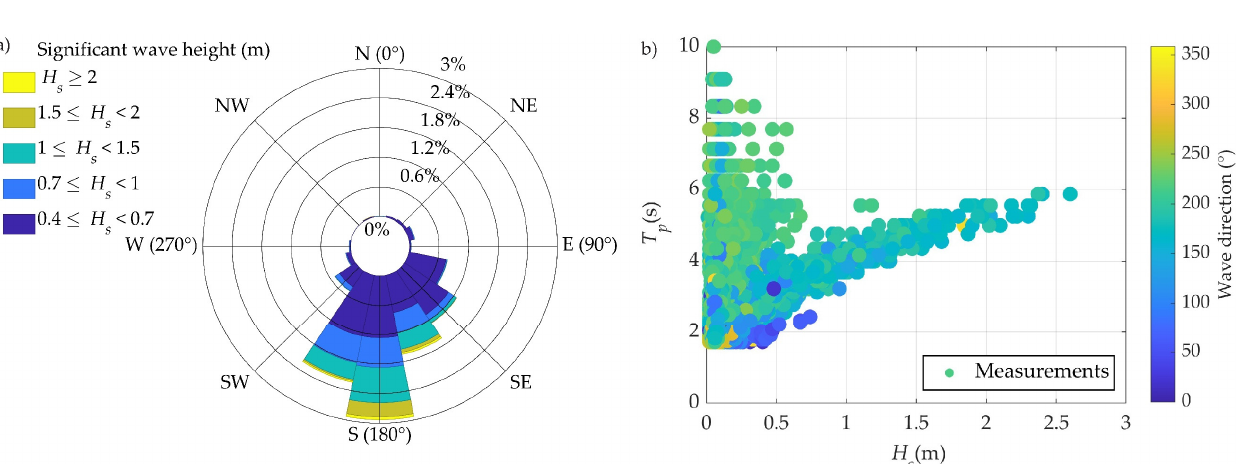
Figure 4. The daily averaged and daily maximum significant wave height values observed in front of the Plo č e beach during the measuring period of December 2019 to April 2021; the camera observation period (wave runup measurements) is indicated with blue vertical lines.